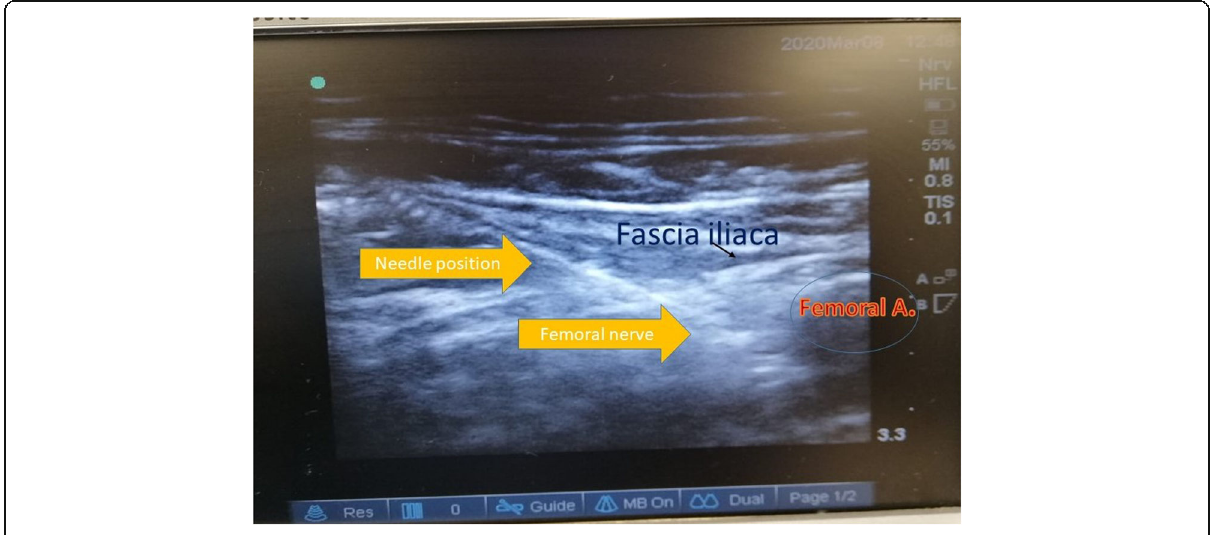
Fig. 2 In plane technique of femoral nerve